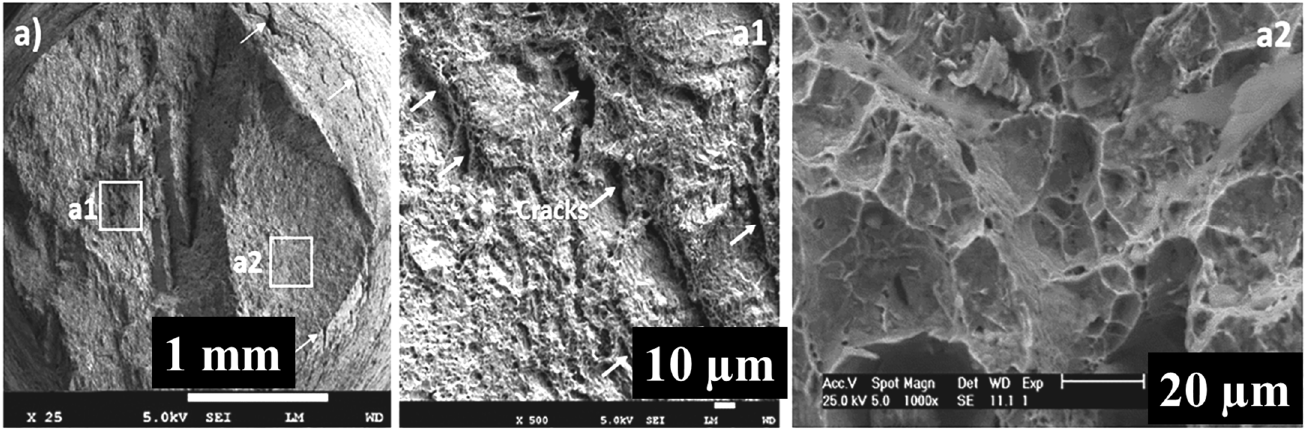
Figure 11. SEM images showing a brittle type of fracture with trans-granular appearance on the X52 exposed specimens in the NS4 solution at pH 5 [67].